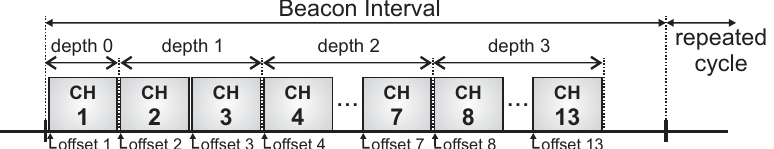
Figure 3. Top-down cluster active period scheduling.